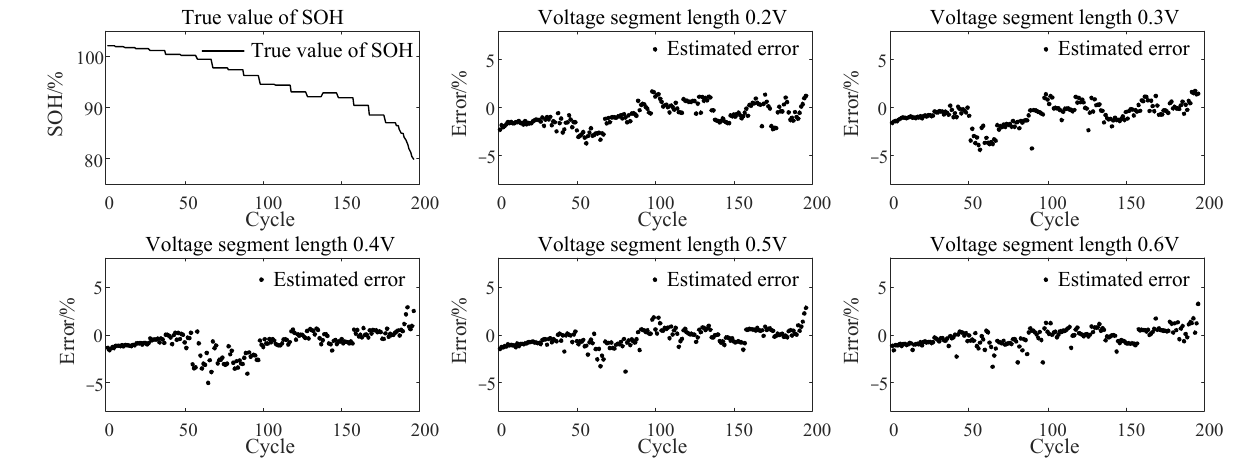
Figure 9. SOH estimation results under 2.0 C discharge.